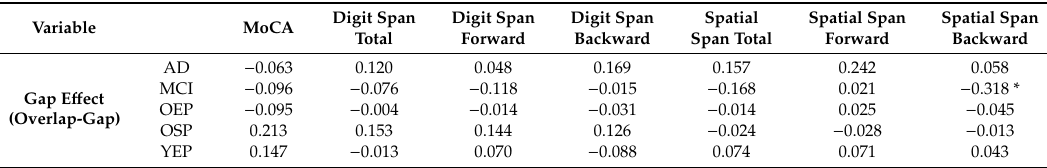
Table 5. Correlations of prosaccade conditions and neuropsychological